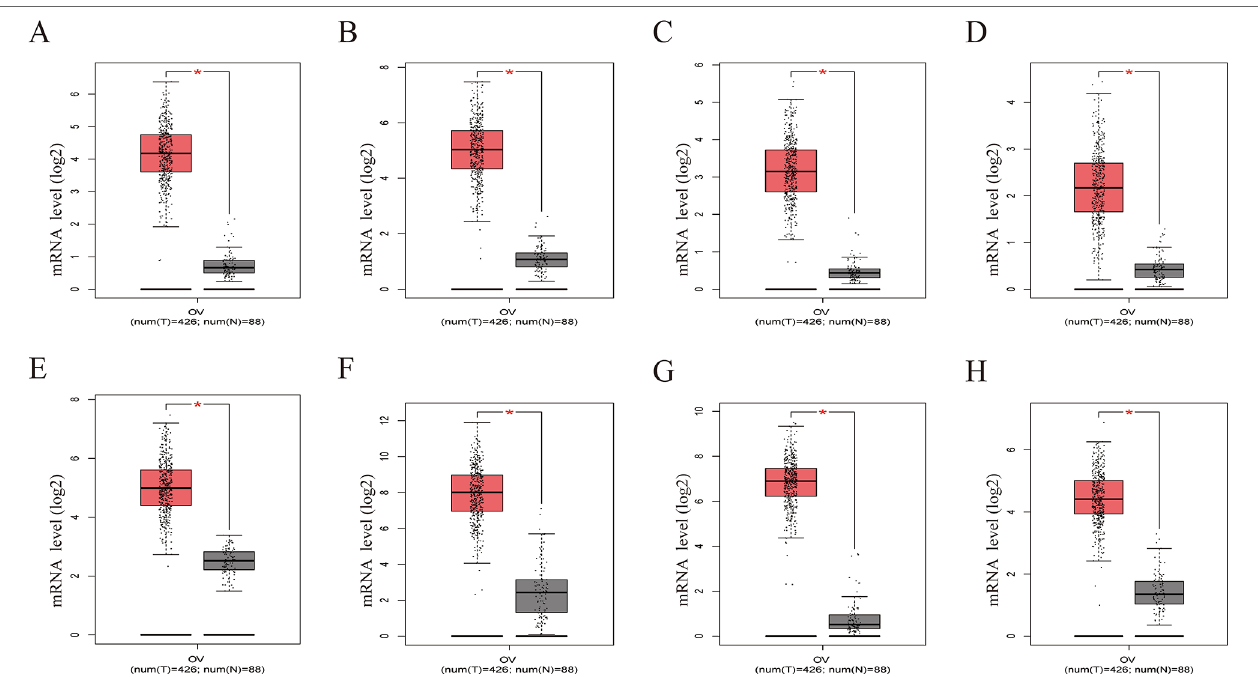
FIgUrE 8 | Gene Expression Profiling Interactive Analysis (GEPIA) was performed to validate higher expression of eight hub genes in EOC samples compared with normal samples. Red box was the cancer tissue group, gray was the normal tissue group, and asterisk represented p < 0.01. The dots represented expression